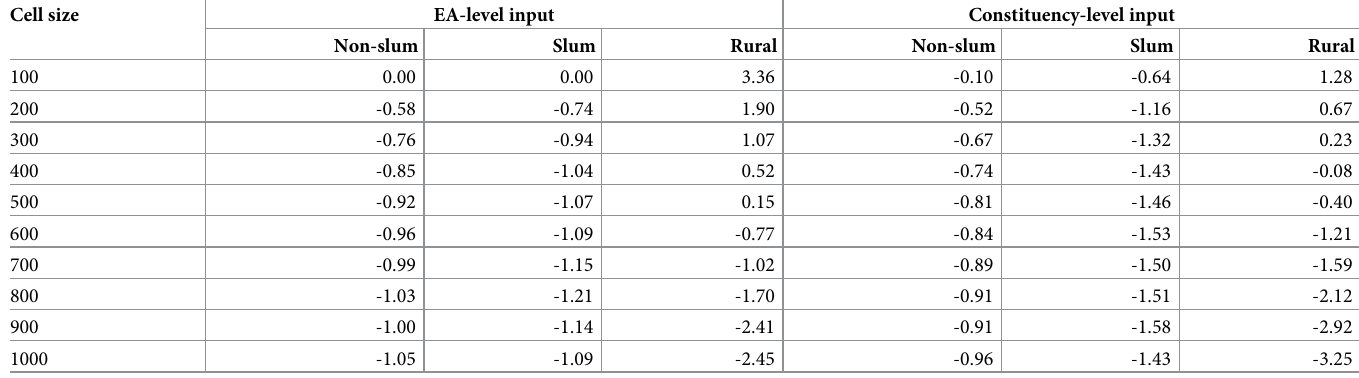
Table 5. Population-adjusted bias in gridded population estimates derived from “true” synthetic population counts, by output grid cell size and urban/rural loca- tion (in cells > = 1 estimated person). Cell